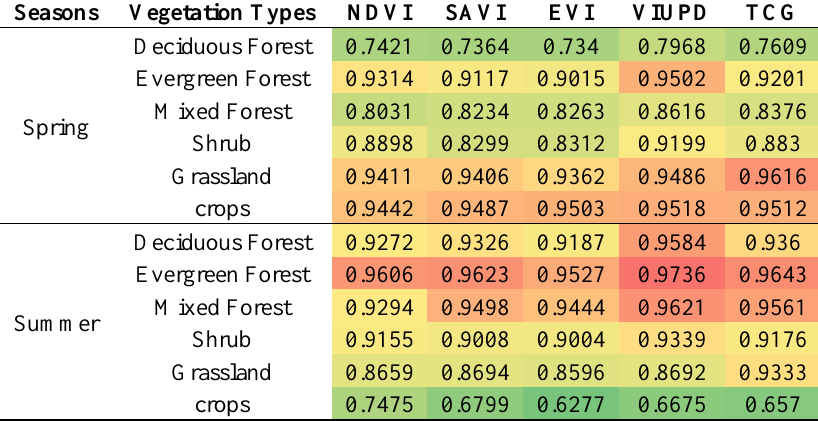
Table 4. Coefficient of determination ( R 2 ) of the regression relationships for the VIs as derived from ETM+ and OLI data for six vegetation classes for the four seasons. A three-color gradient (green-yellow-red) is used to colorize the R 2 value in each cell from small to